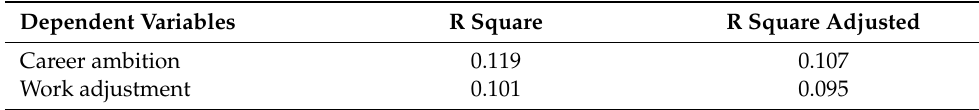
Table 6. Variance Explained (R 2 ).